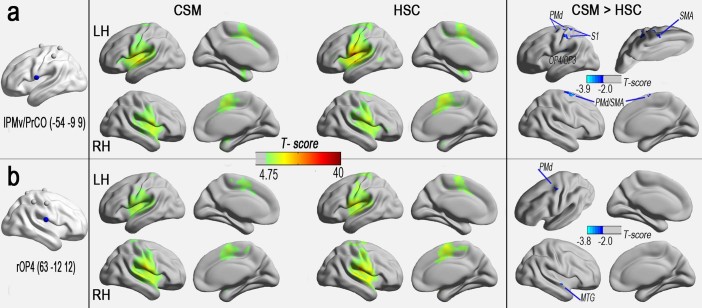
Significant positive rsFC patterns (P < 0.001, FDR corrected) of the seed regions with decreased FCS were observed, as were significant differences (P < 0.05, AlphaSim corrected critical cluster size was k = 24 in Fig 4a and 4b) between the CSM and HSC groups.Left column: seed regions with decreased FCS in patients with CSM; middle column: rsFC patterns connected with the seed regions in both the CSM and HSC groups; right column: group differences in rsFC between the two groups. The colour-bars indicate the t-scores. Yellow-red colours denote highly positive rsFC in one-sample t-tests (one group), and cyan-blue colours denote decreased rsFC in CSM patients.